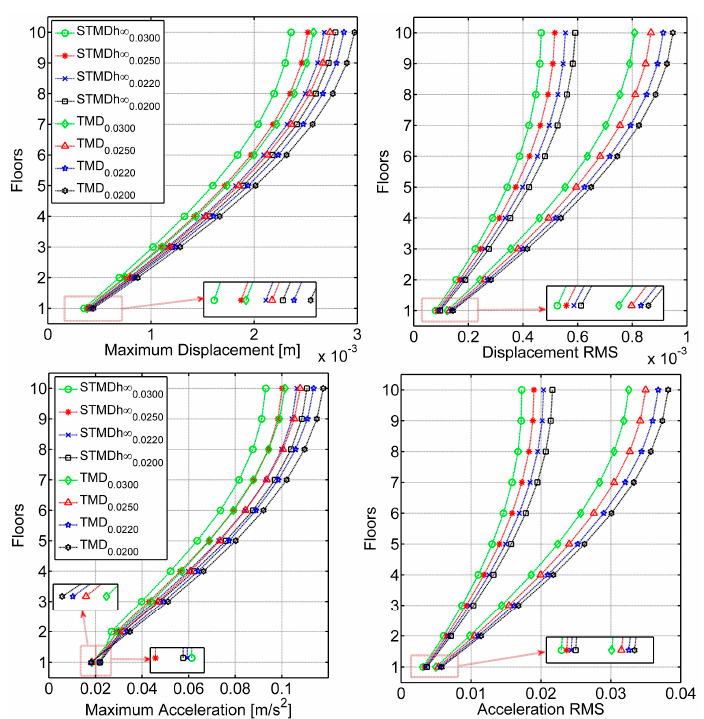
Figure 9. The maximum displacement (left-top), maximum acceleration (left-bottom), displacement RMS (right-top), and acceleration RMS (right-bottom) values of all floors under the Excitation-1 force. For the Excitation-2 force, the displacements and accelerations of the 10th floor in the cases the TMD 0.0300 and the STMDh ∞ 0.0300 are indicated in Figure 10. The STMDh ∞ 0.0300 seems to be more successful in suppressing acceleration and displacement responses than the TMD 0.0300 .